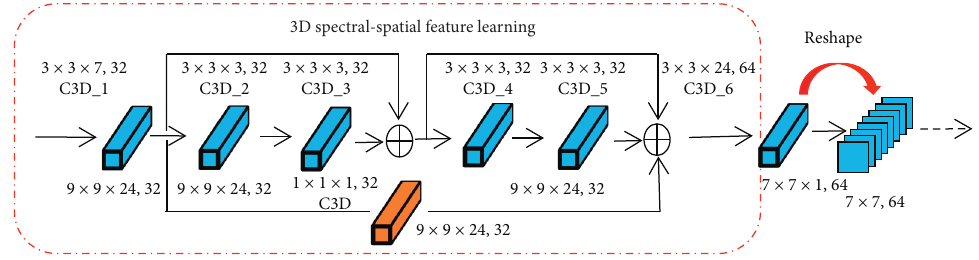
Figure 2: 3D spectral-spatial feature learning.